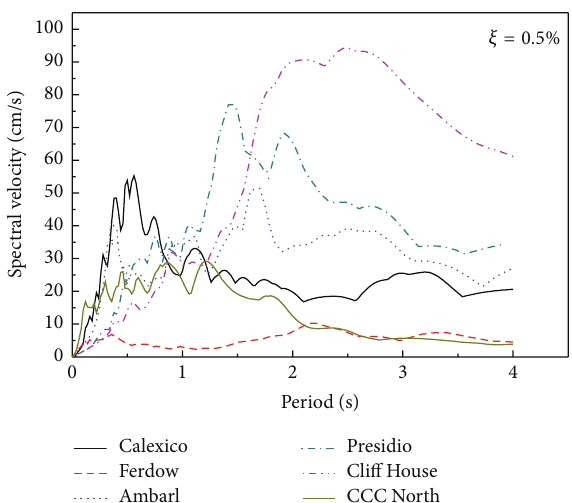
Figure 12: Velocity spectra of far-fault ground motions.